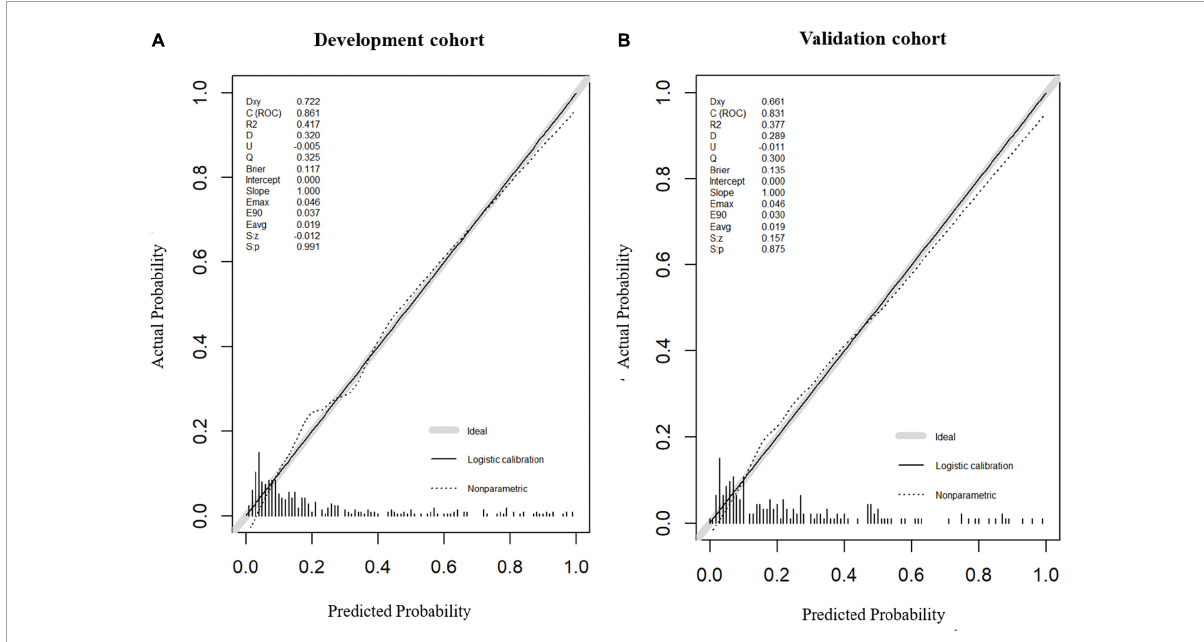
FIGURE4 Calibration plot of nomogram in the development cohort and the validation cohort. Calibration curves for the 1-year functional outcomes, which are representative of predictive accuracy, for the development (A) and the validation cohorts (B)